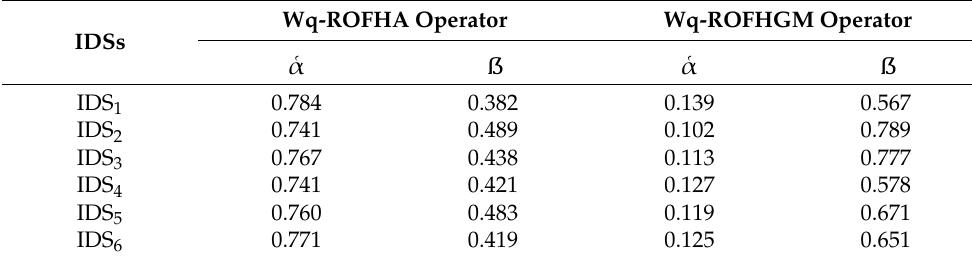
Table 4. Combined evaluation matrix for alternatives in terms of the criteria based on q-ROFN. Alternatives (Intrusion-Detection Systems) Criteria